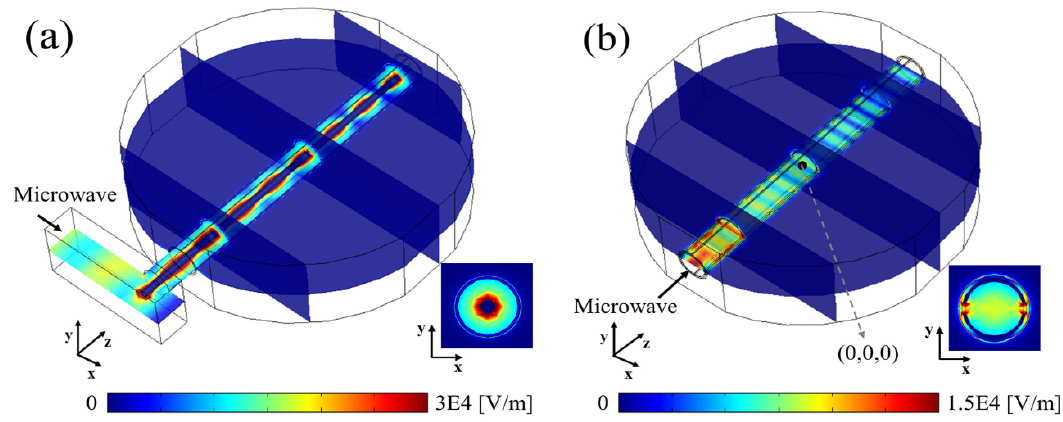
Figure 8. Electric field norm |𝐸| (E-field amplitude, (cid:3495)𝐸 (cid:3051)(cid:2870) + 𝐸 (cid:3052)(cid:2870) +𝐸 (cid:3053)(cid:2870) ) simulation results. ( a ) TEM mode of quasi-coaxial linear MWP and ( b ) circular TE 11 mode waveguiding structure MWP.